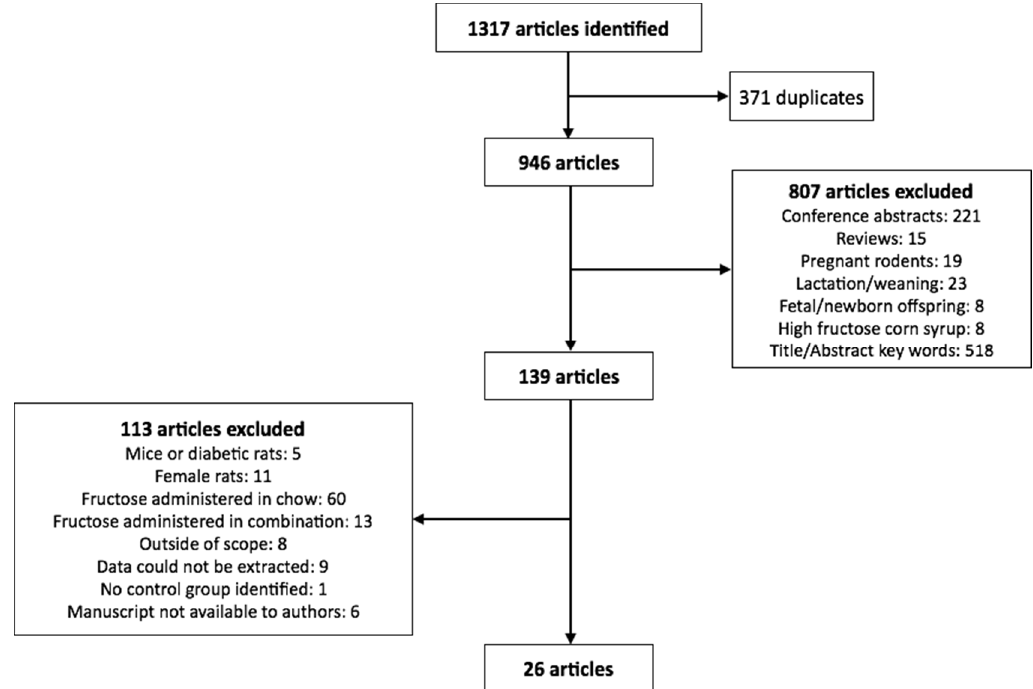
Figure 1. Flowchart of studies selected for the meta ‐ analysis.